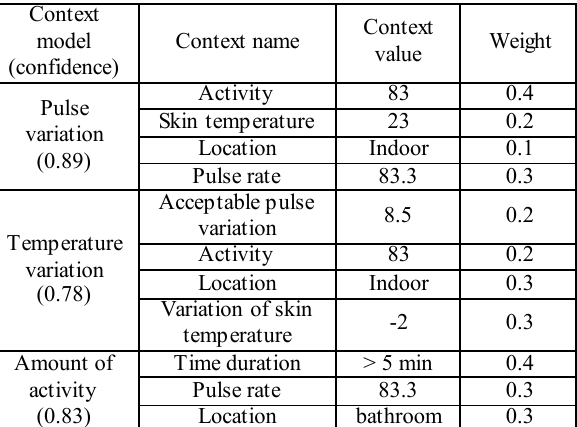
Table 4. An example of context models of emergency